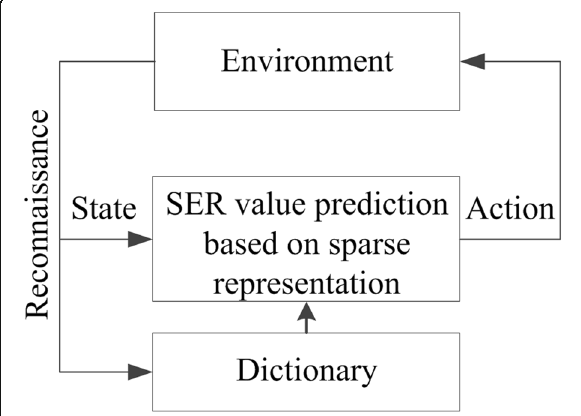
Fig. 2 Process of jamming with SER value prediction.